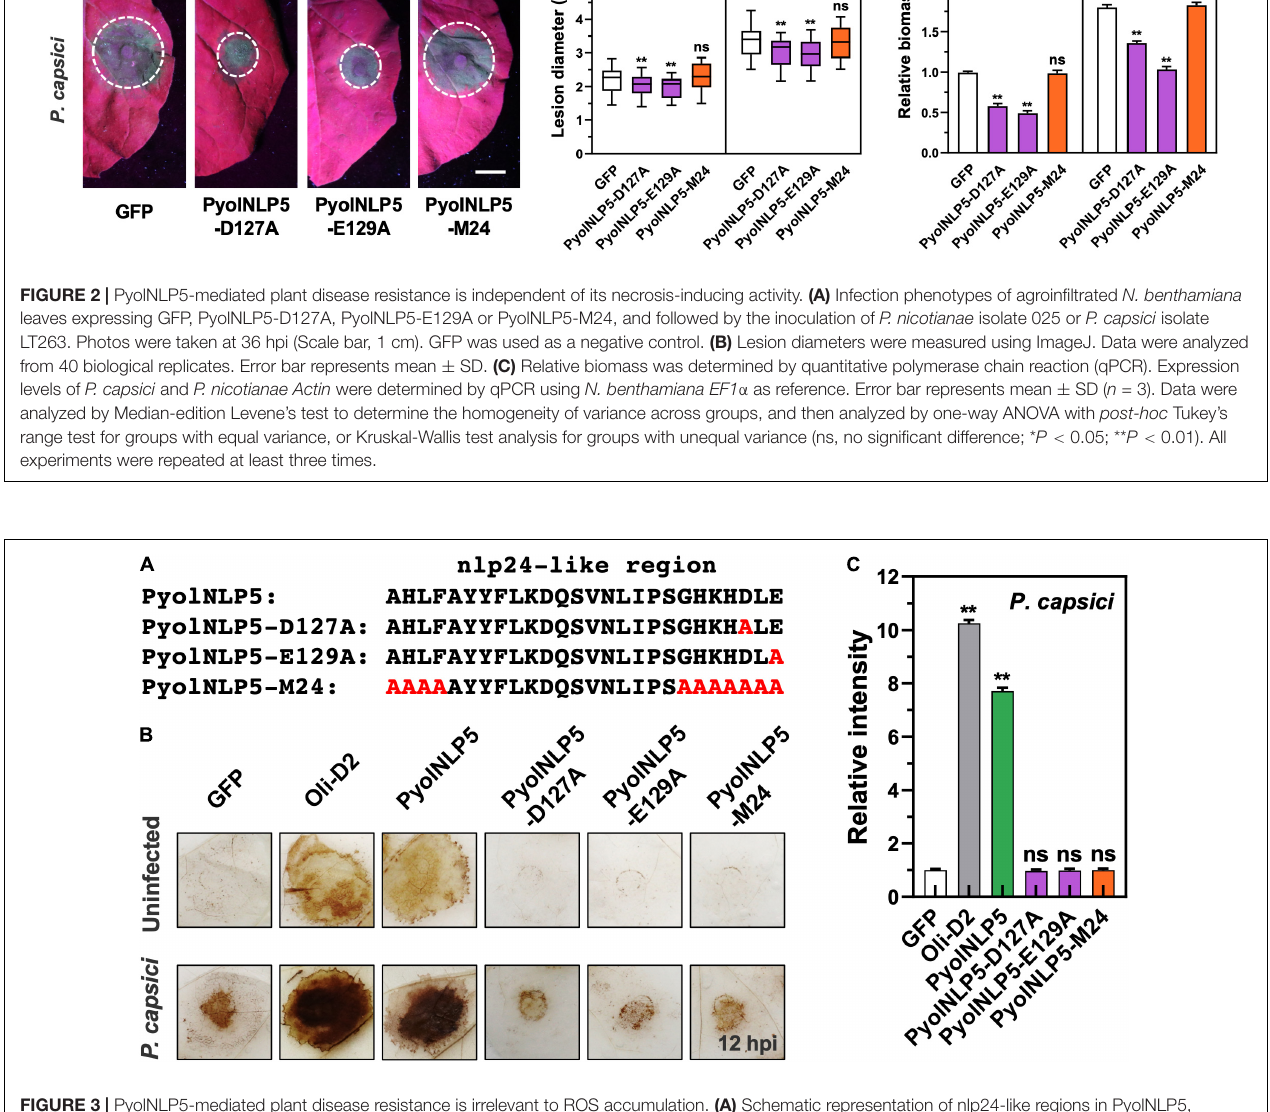
FIGURE 3 | PyolNLP5-mediated plant disease resistance is irrelevant to ROS accumulation. (A) Schematic representation of nlp24-like regions in PyolNLP5, PyolNLP5-D127A, PyolNLP5-E129A and PyolNLP5-M24 with introduced alanine substitutions. (B) H 2 O 2 accumulation on agroinfiltrated N. benthamiana leaves expressing GFP , Oli-D2 , PyolNLP5 , PyolNLP5-D127A , PyolNLP5-E129A or PyolNLP5-M24 . Oli-D2 was used as a positive control. DAB staining was performed at 12 hpi after P. capsici inoculation. (C) Relative ROS intensities in infiltrated N. benthamiana leaves expressing wild-type or mutated PyolNLP5 were measured at 12 hpi using ImageJ. Error bar represents mean ± SD ( n = 3). Data were analyzed by Median-edition Levene’s test to determine the homogeneity of variance across groups, and then analyzed by one-way ANOVA with post-hoc Tukey’s range test for groups with equal variance (ns, no significant difference; ** P < 0.01). Experiments were repeated three times with similar results